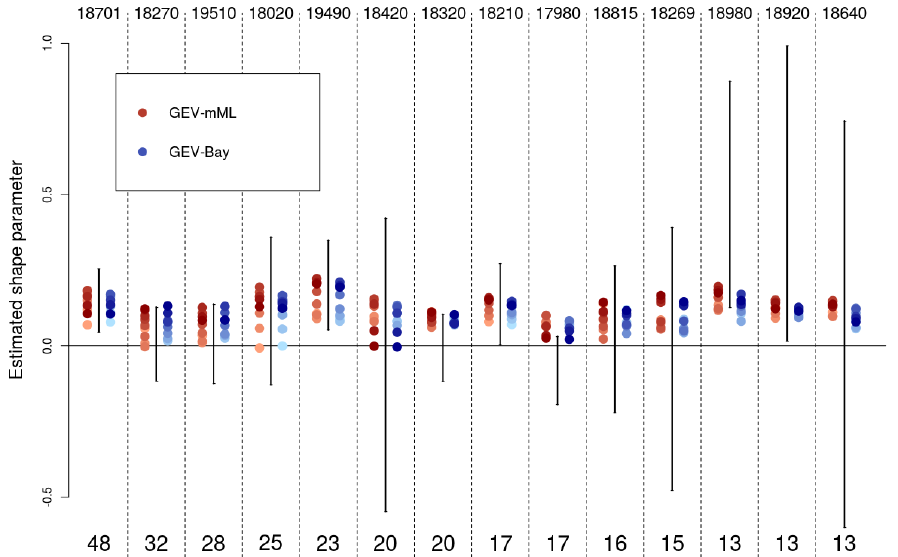
Figure 6. The GEV shape parameter estimated with GEV-mML (red) and GEV-Bay (blue) for all durations (vertically) and stations (horizontally). The black lines show the minimum and the maximum shape parameter estimated by ordinary ML. The different shades indicate the duration, from light (short-duration) to dark (long duration). Stations are sorted by time-series length (number on the bottom) from left to right. Station numbers are indicated on the